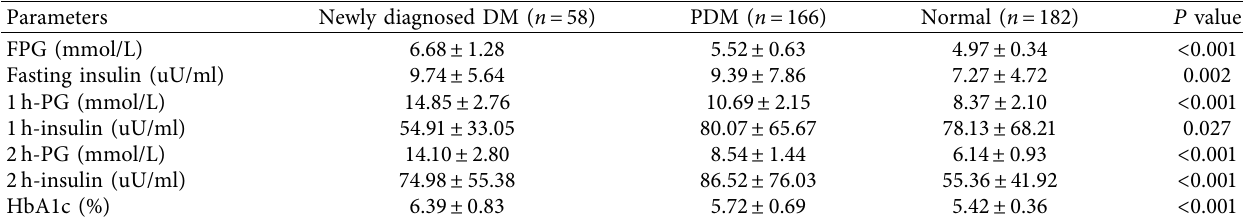
Table 2: Baseline FPG, insulin, and HbA1c levels of study participants.